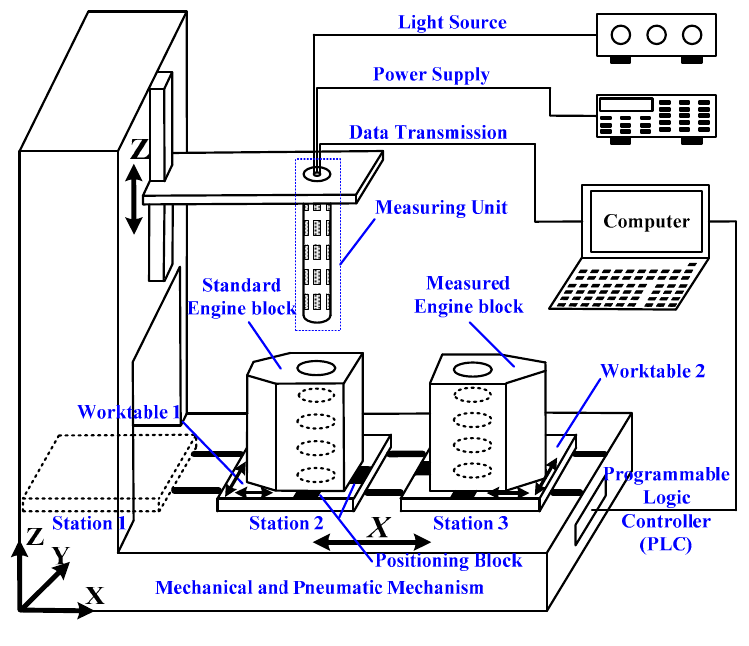
Figure 2. The measuring system.